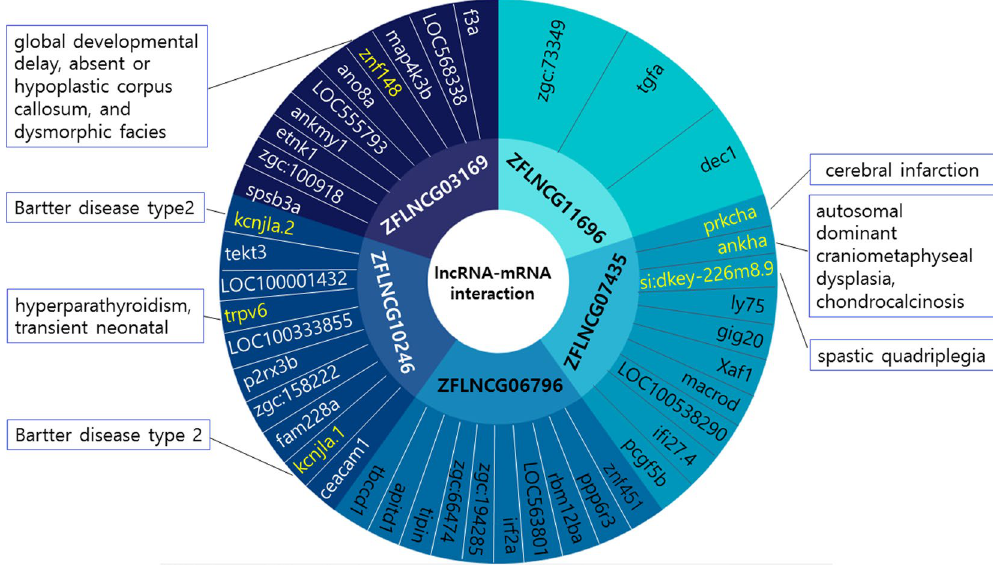
Figure 5. lncRNA–mRNA (protein-coding gene) interaction network for 5 out of 8 conserved lncRNAs in zebrafish. Among the eight candidates, five (ZFLNCG11695, ZFLNCG07435, ZFLNCG06796, ZFLNCG10246, and ZFLNCG03169) of which were identified as having related protein-coding genes of zebrafish, and three (ZFLNCG07435, ZFLNCG10246, and ZFLNCG03169) of which were identified as having genes (prkcha, ankha, si:dkey-226m8.9, kcnjla.2, trpv6, kcnjla.1, and znf148) related to human disorder. Information provided by ZFLNC (http:// www. zflnc. org/) and zfin (https:// zfin.